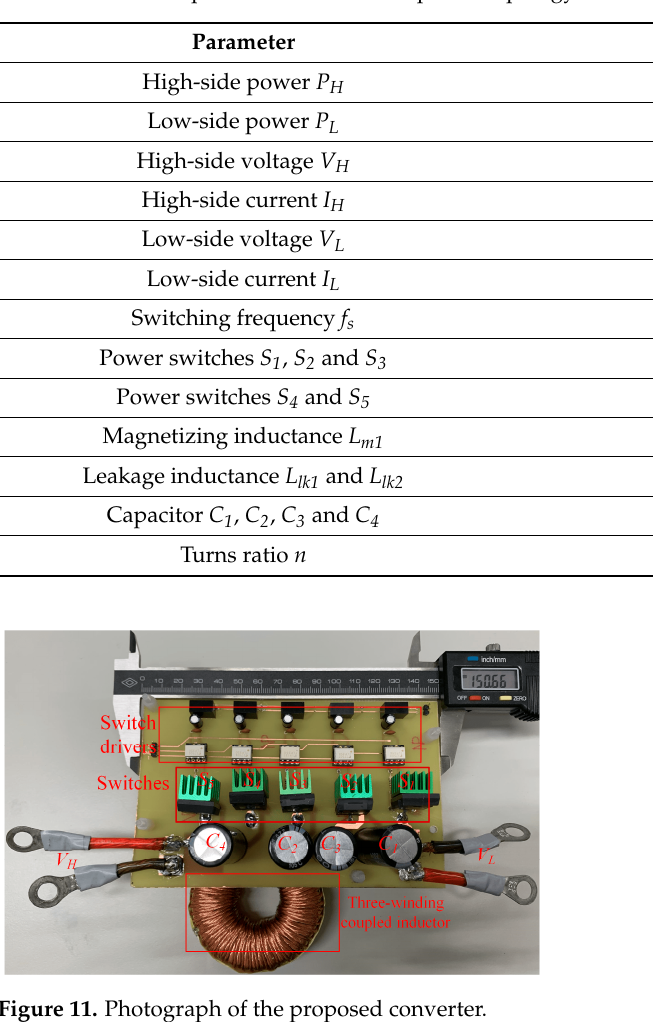
Table 1. Electrical Specifications of the Proposed Topology.